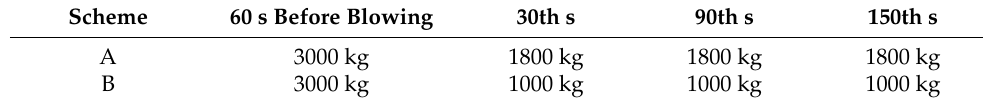
Table 4. Schemes of coolant addition.